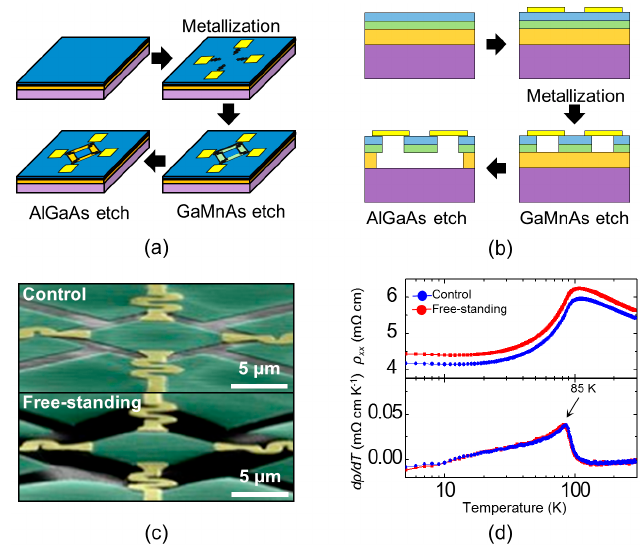
Figure 2. ( a ) Schematic illustration of the fabrication of a free-standing GaMnAs microsheet with integrated electrical leads suitable for use in van der Pauw measurements. ( b ) Cross-sectional schematic view of fabrication process. ( c ) SEM image of control ( top ) and free-standing ( bottom ) van der Pauw structures with added false color to distinguish the GaMnAs layer (green) and electrical leads (gold). ( d ) Temperature-dependent resistivity ( ρ xx vs. T ) and the corresponding differential resistivity ( d ρ xx / dT ).